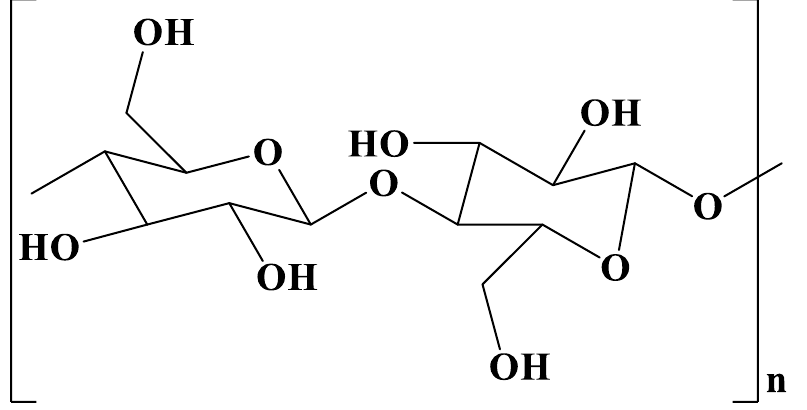
Figure 1. Chemical structure of